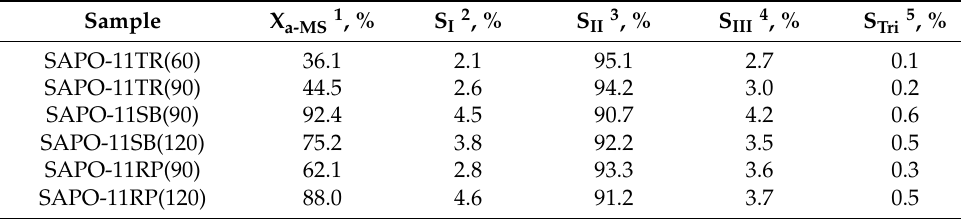
Table 7. Oligomerization of α -methylstyrene over SAPO-11 molecular Table 7. O ligomerization of α -methylstyrene over SAPO-11 molecular sieves.